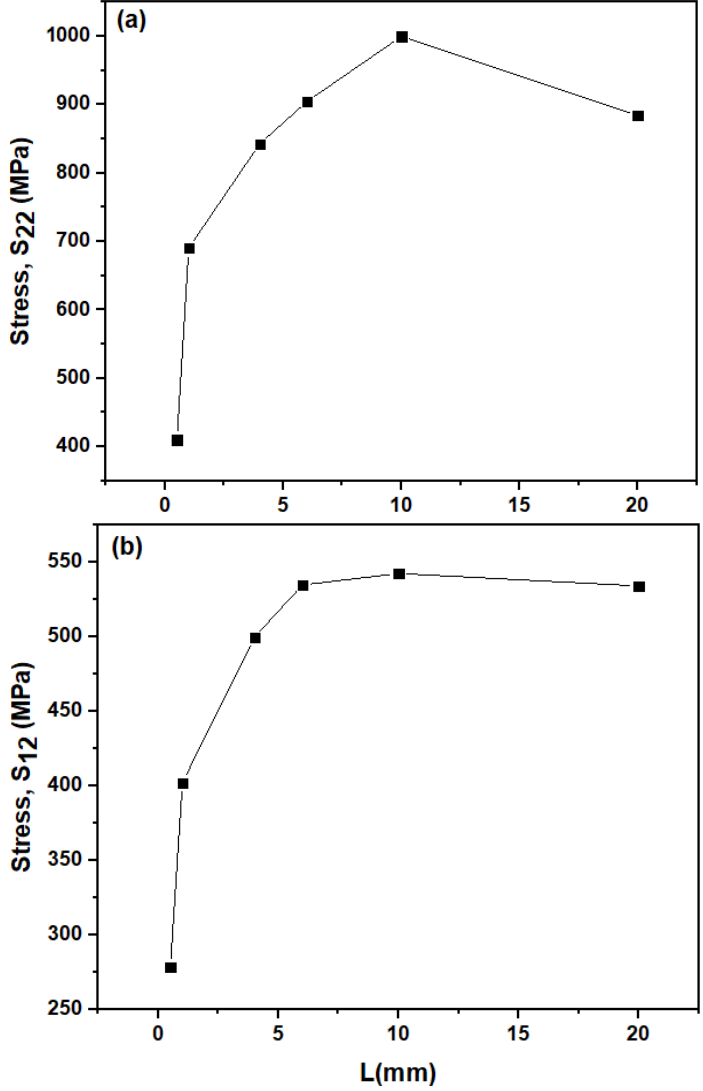
Figure 5. Stress distribution ( a ) S 22 and ( b ) S 12 at the pre-crack tip. The values of SERR at the tip of the pre-crack must be assessed and compared with the fracture toughness of the top-coat, with the aim of simulating the delamination of coating and crack propagation [25]. The effect of the SVC on the SERR of the thermal barrier coating system analyzed in this section is stimulating, and suggests the possibility of enhancing the durability of TBCs by modifying the morphology of surface crack. In Figure 6, three regions (I, II, and III) can be seen to segregate the effect of the SVC on SERR. In region I, the SVC has a strong influence on the crack-driving force. In this case, the investigation of crack propagation and delamination of coating can be restricted and retarded. In the transition region (region II), the influence of the SVC slowly reduces as the delamination propagates. In the stable region (region III), the influence of crack spacing between two vertical cracks is unimportant and may be disregarded. It is considered that the crack-driving force of a coating does not depend upon the SVC, as the SVC is large enough-roughly ten times ( L ≥ 20 mm) the ceramic top-coat thickness of the present